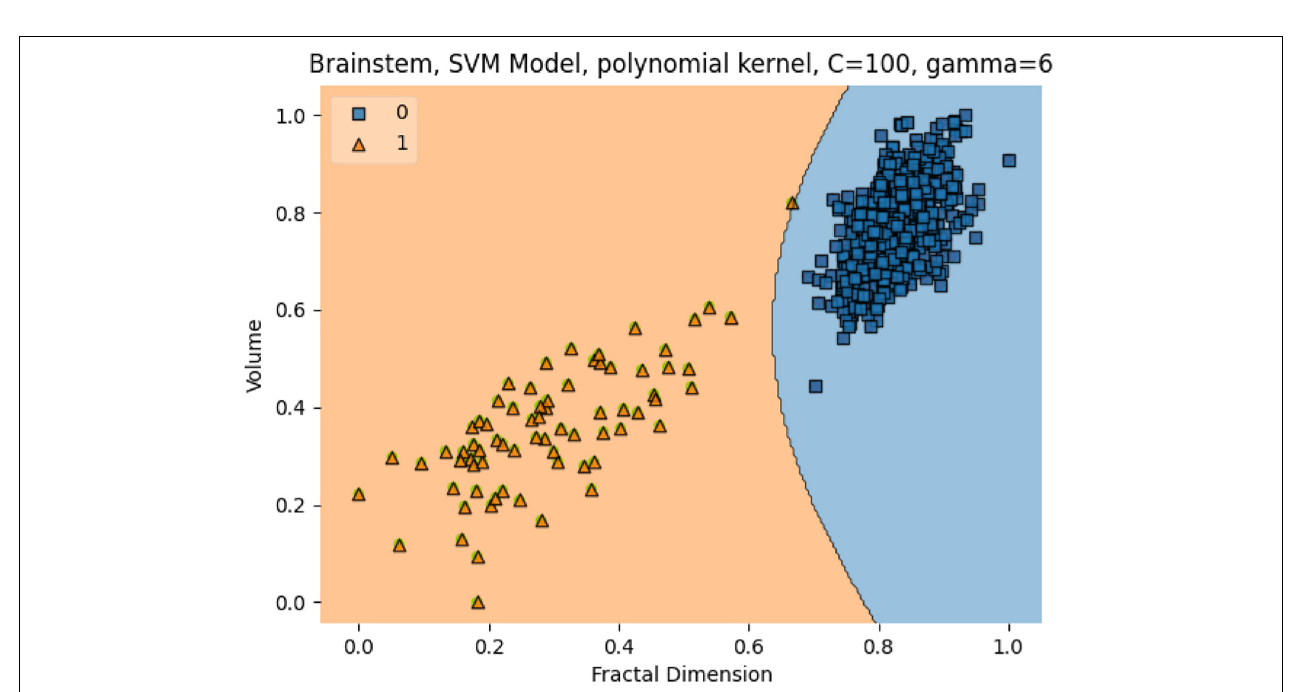
FIGURE 14 | The SVM model separating the two groups. Features are Volume and FD. Hyperparameters are regularization hyperparameter C = 100 and gamma = 6 with polynomial kernel.